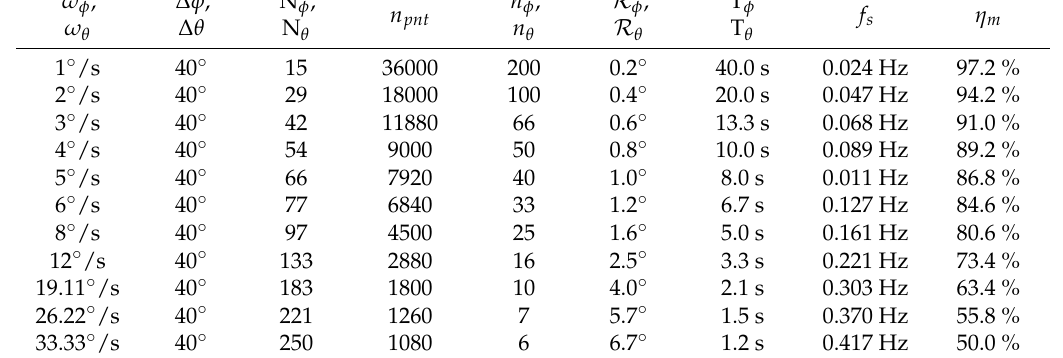
Table 1. Simulated LiDAR trajectories of cross-measurements for n r = 180 and T = 600 s.